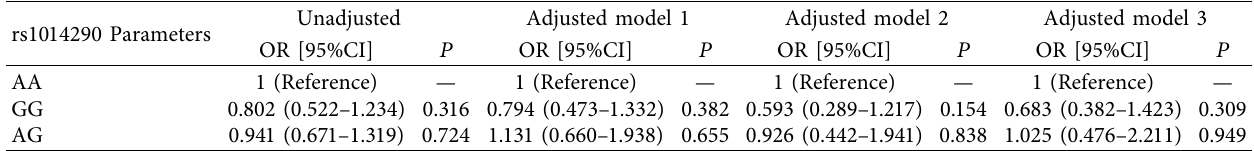
Table 4: Binary logistic regression analysis for pre-DM risk.